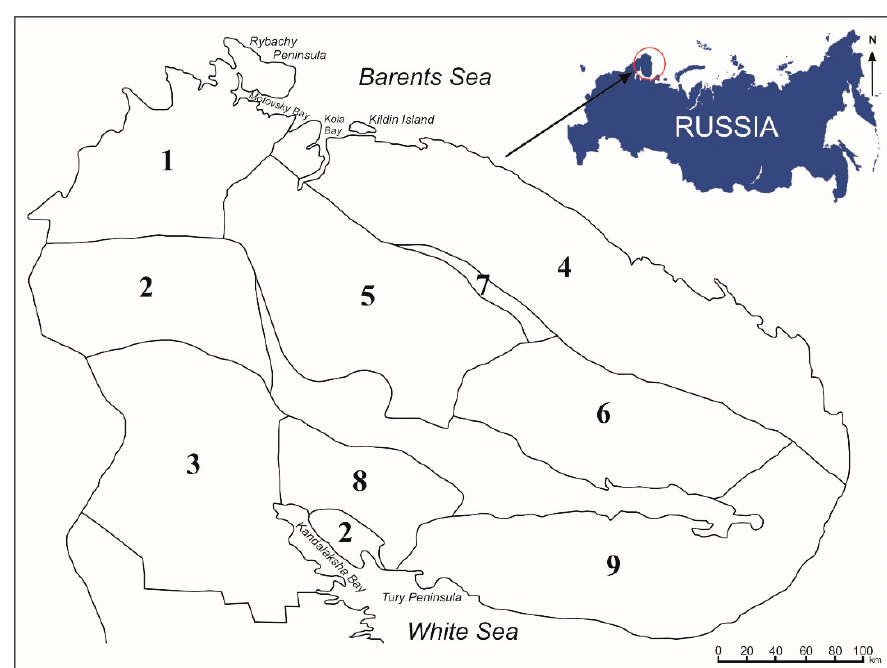
Figure 9. Metallogenic areas in the Murmansk region (Modified from [5]): 1—Pechenga ‐ Allarechka area (nickel, copper, cobalt, sulphur, gold, silver, platinum, palladium, rhodium, ruthenium, iridium, selenium, tellurium, mica and ceramic pegmatites); 2—Lapland ore area (copper, nickel,